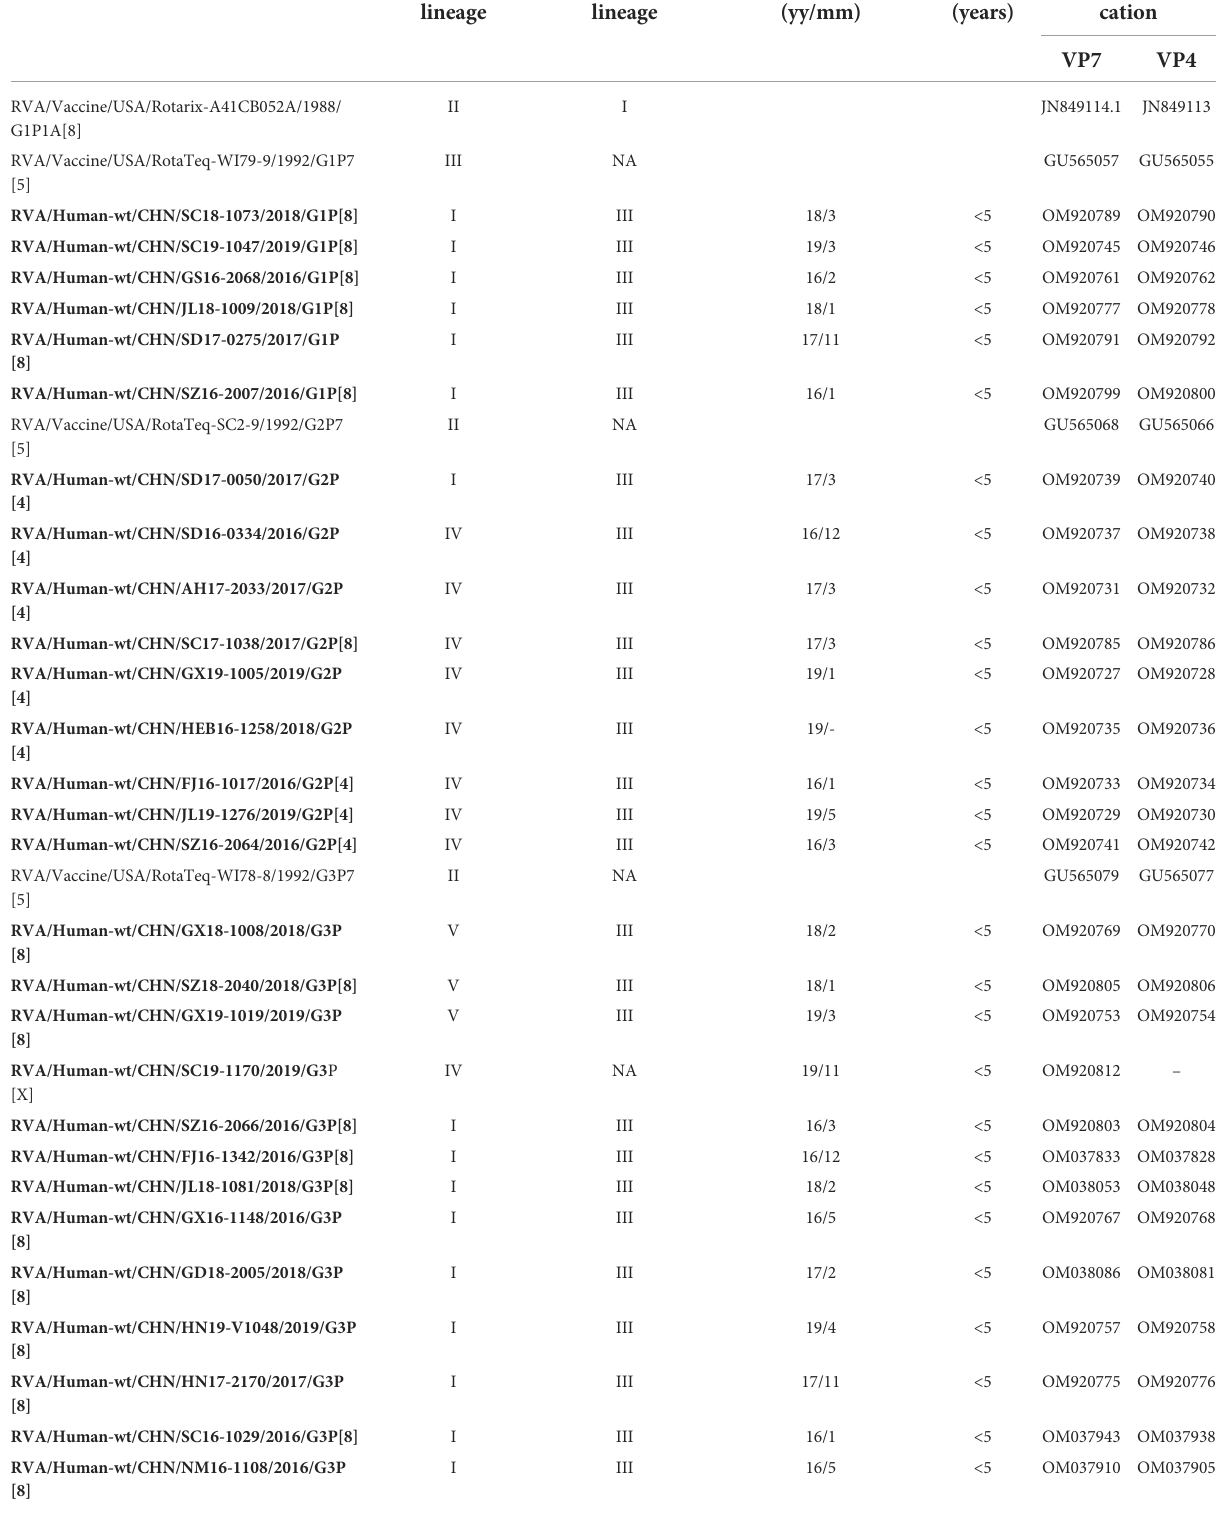
TABLE 1 VP7 and VP4 lineage, date of isolation, and patient information for the Chinese rotavirus strains analyzed in this study and vaccine strains.